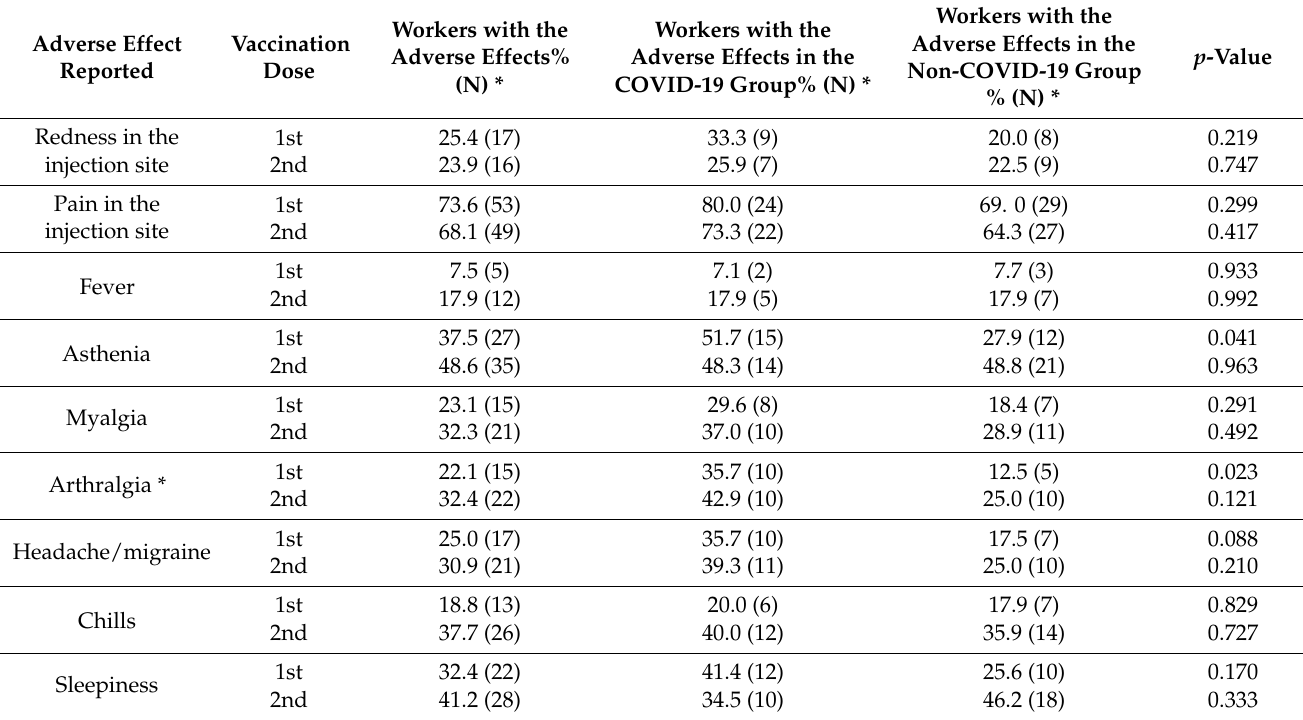
Table 2. Frequency of main adverse effects reported by the workers after the first and the second dose of the BNT162b2 anti-SARS-CoV-2